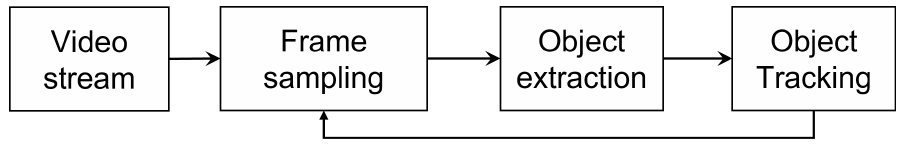
Figure 13. Overview of the object tracking